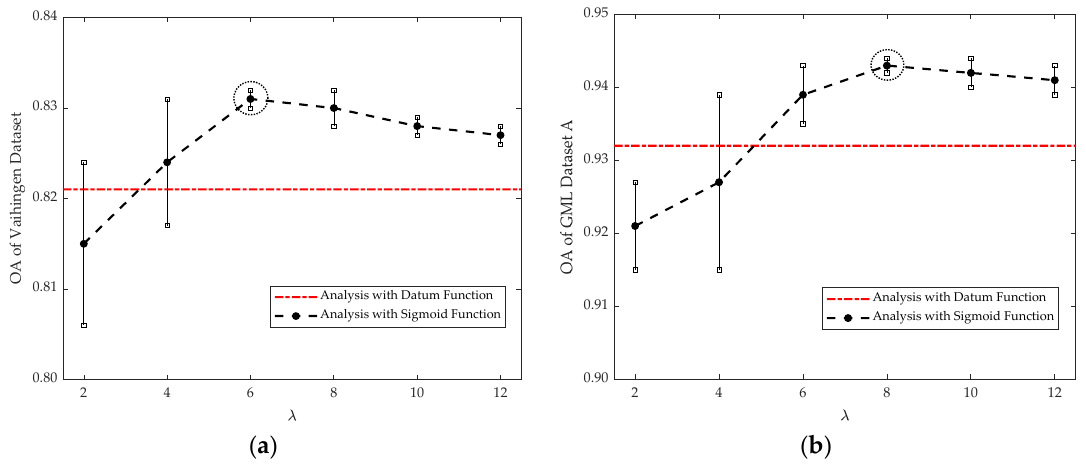
Figure 15. Sigmoid functions with different λ in the interval from 0 to 1.